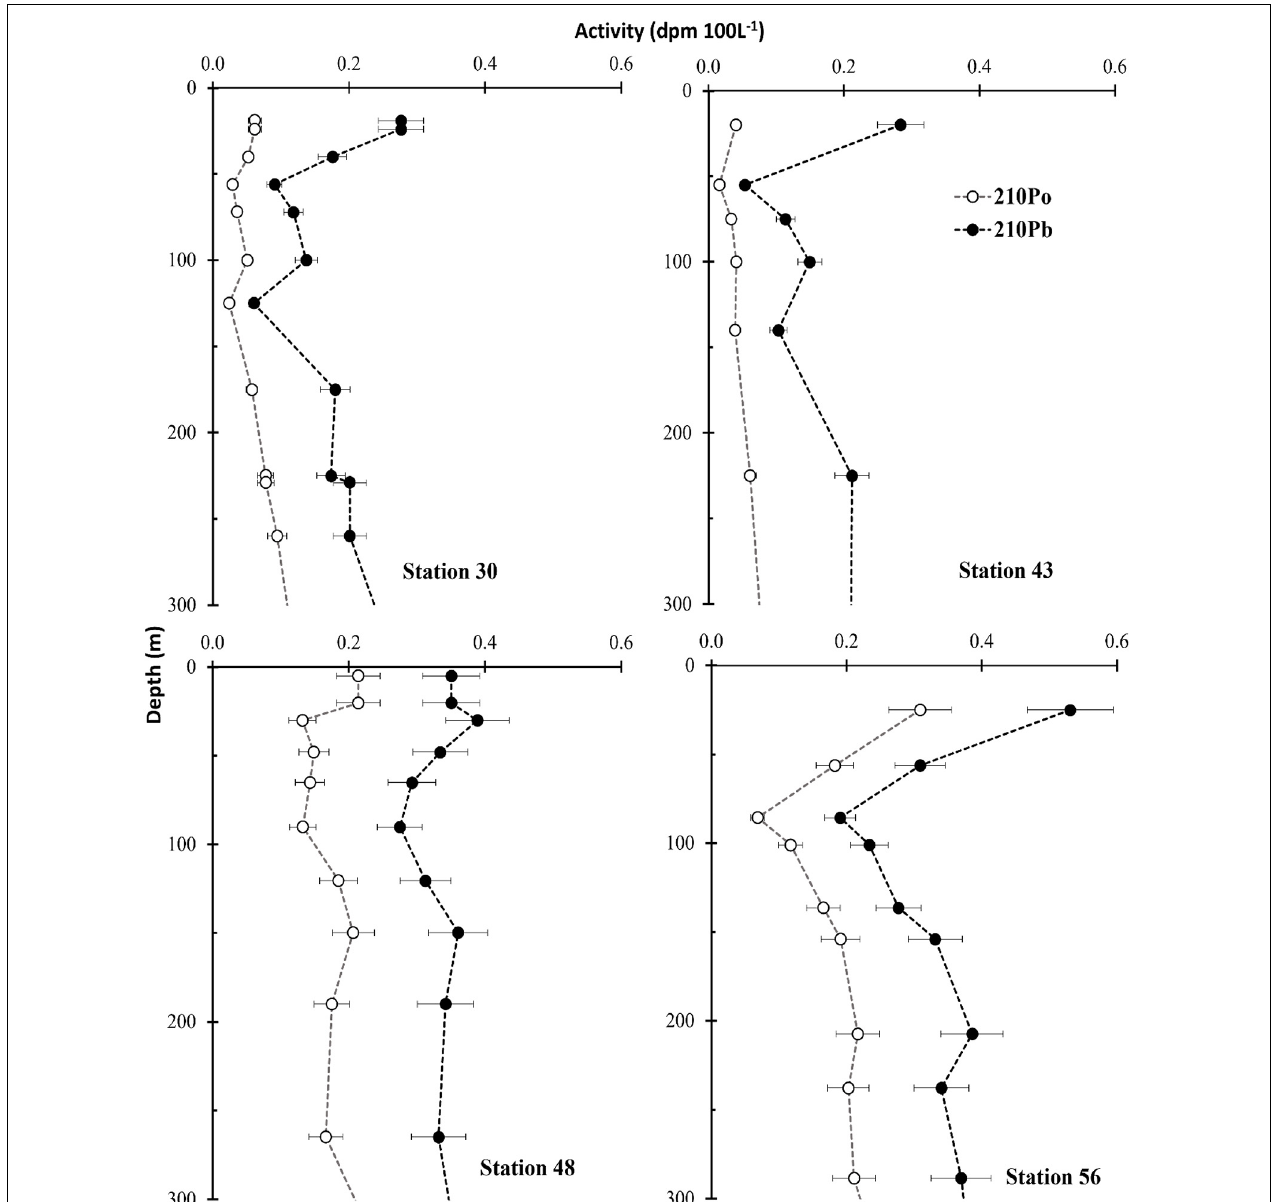
FIGURE 5 | The water column profile of large particulate 210 Po (open circle) and 210 Pb (filled circle) at each station.